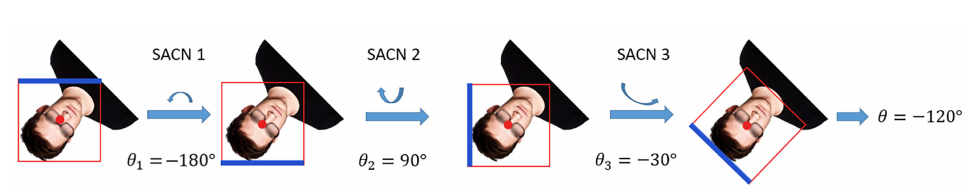
Figure 7. The final rotated angle is calculated by the sum of three